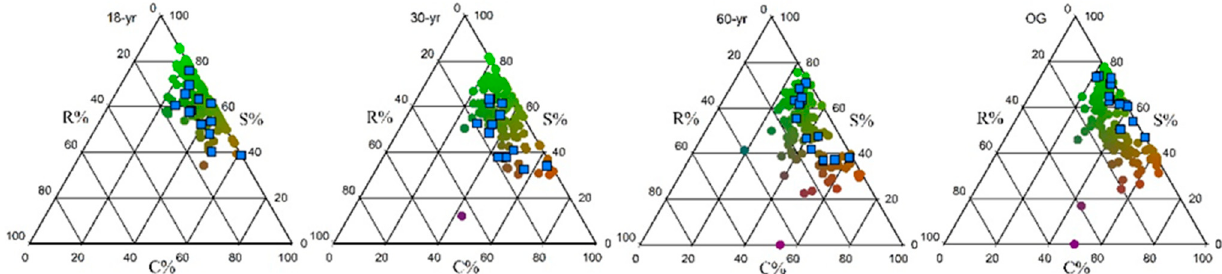
Figure 2. A ternary diagram showing CSR strategy values of co-existing tree species in different successional stages of tropical rain forest. The blue square represents the strategic average of each species feature ( n = 13), while the circle represents the individual strategic value of a single species ( n = 104). C (%), S (%), and R (%) respectively represent the scores of C, S, and R in the C-S-R triangle. Ecological strategies are represented by red (C), green (S), and blue (R) ecological strategies, and mixed colors represent mixed strategies (e.g., red/green = CS strategy).